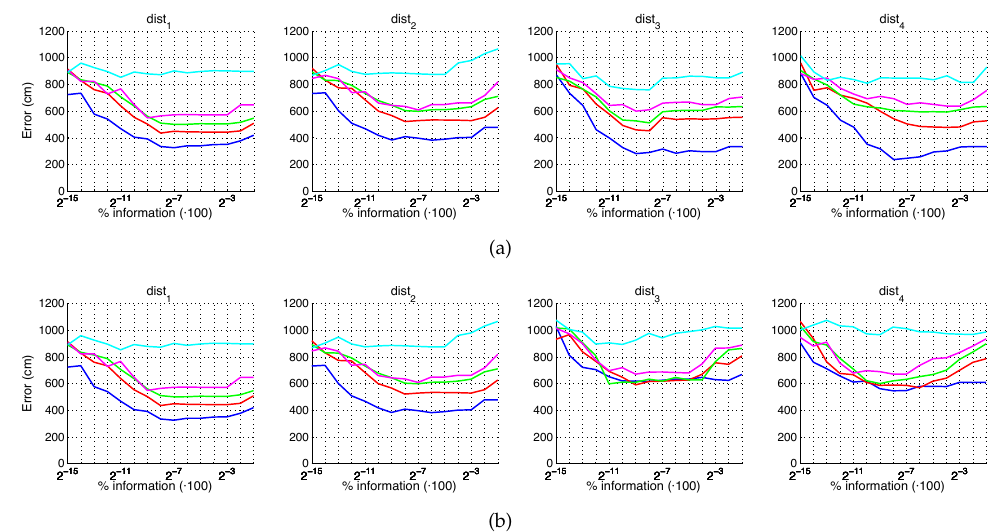
Figure 25. Gist average localization error with occlusions: ( a ) no filter and ( b ) homomorphic filtering.